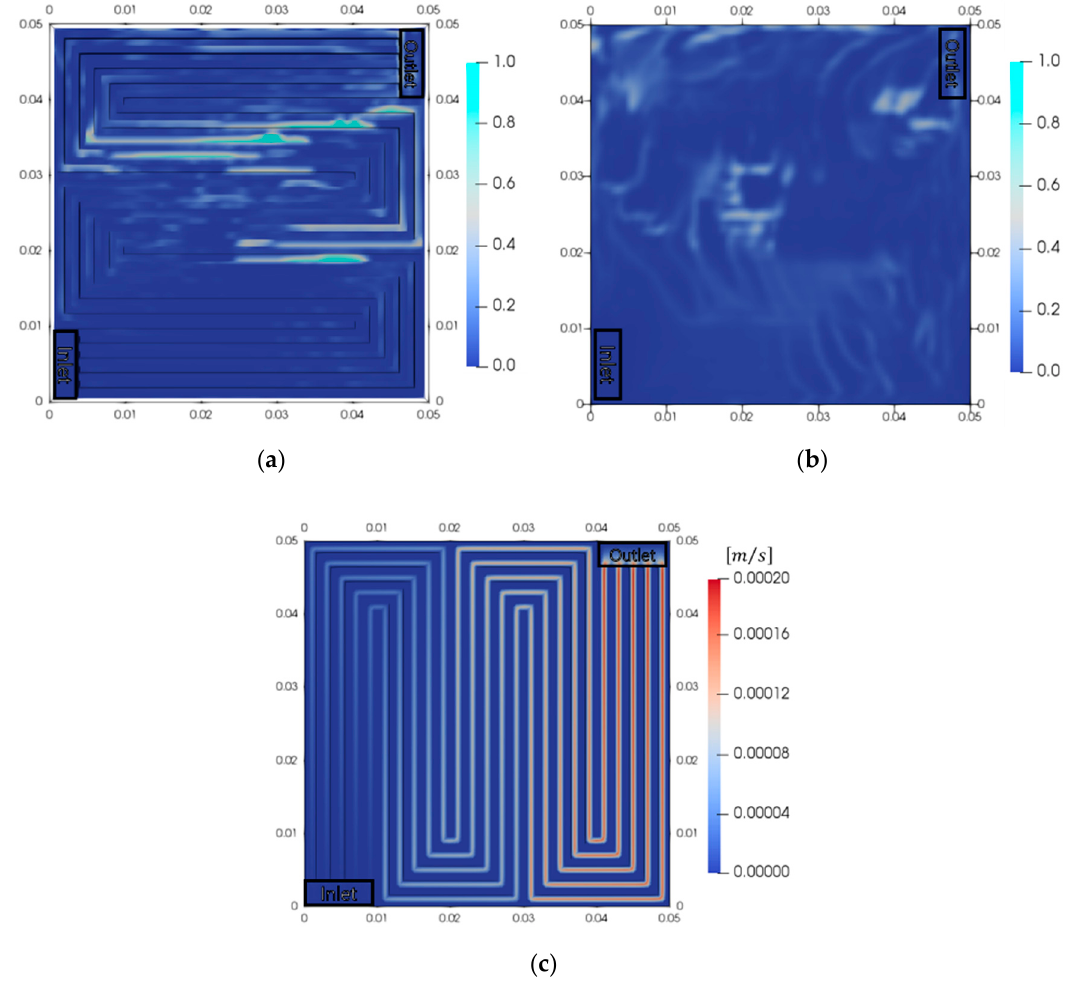
Figure 5. Fluid distributions in anode and cathode at a current density of 10,000 A/m 2 . ( a ) Volume fraction of oxygen in the channel, ( b ) volume fraction in the porous transport layer (PTL), and ( c ) hydrogen velocity in the cathode.